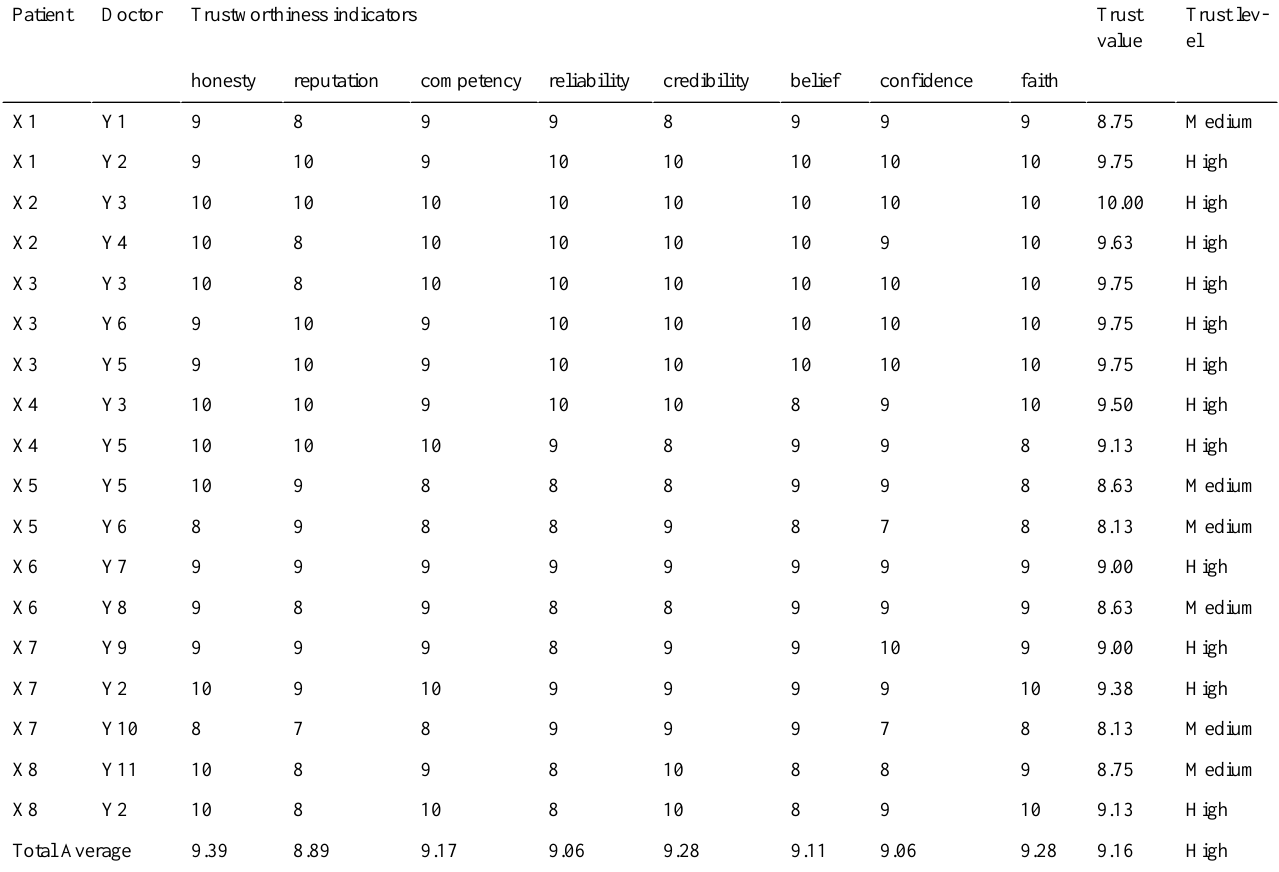
Table 7. Patient ratings of several physicians in a chat room.